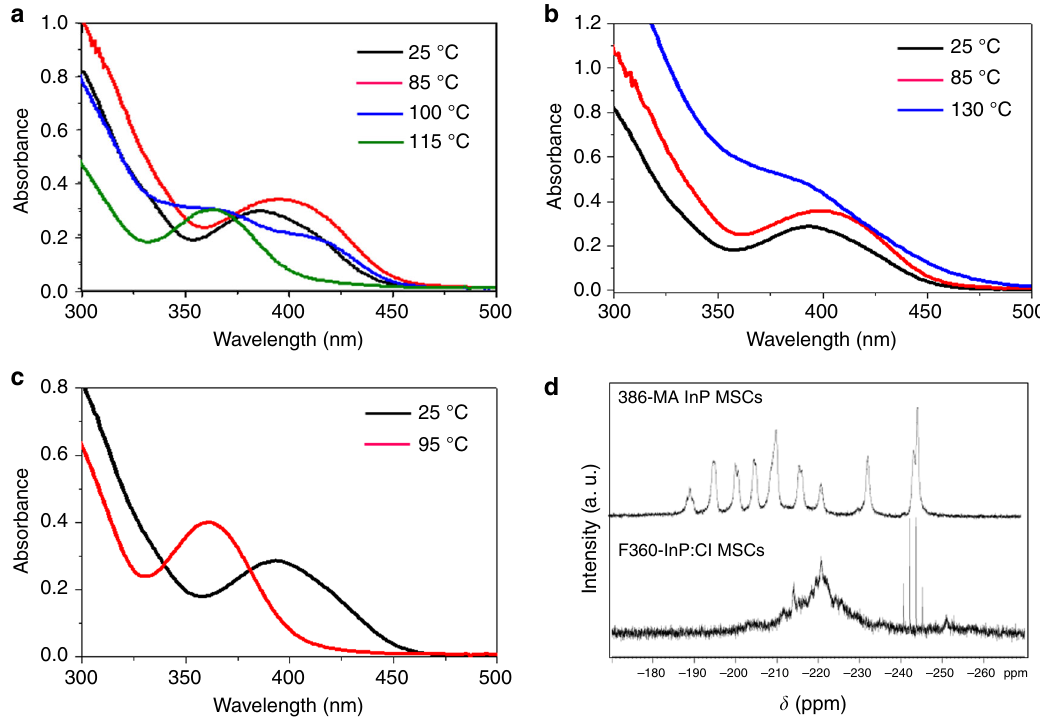
Fig. 3 Conversion from 386-InP MSC to F360-InP:Cl MSCs. UV − vis absorption spectra of aliquots taken over time a during conversion from as- synthesized 386-OA InP MSCs to F360 InP:Cl MSCs using 56 equivalents of InCl 3 , b during conversion reaction from puri fi ed 386-OA InP MSCs using 56 equivalents of InCl 3 , and c during conversion from puri fi ed 386-OA InP MSCs to F360 InP:Cl MSCs using 56 equivalents of InCl 3 and 112 equivalents of OA.